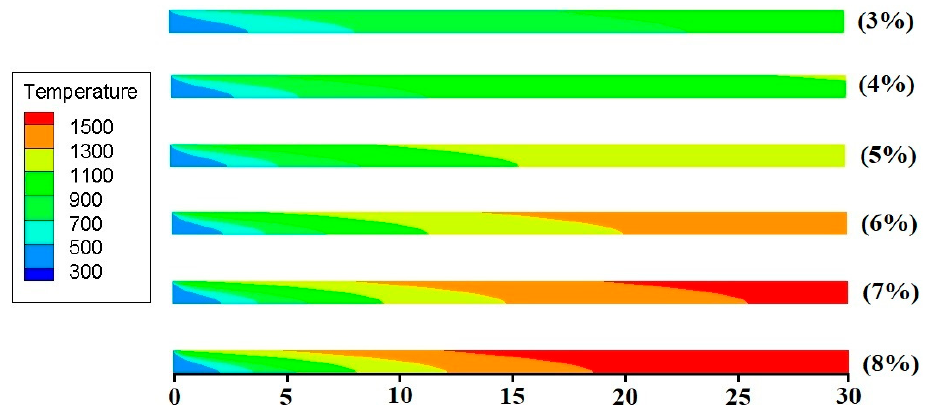
Figure 7. Temperature distribution of exhaust gas with different methane contents.